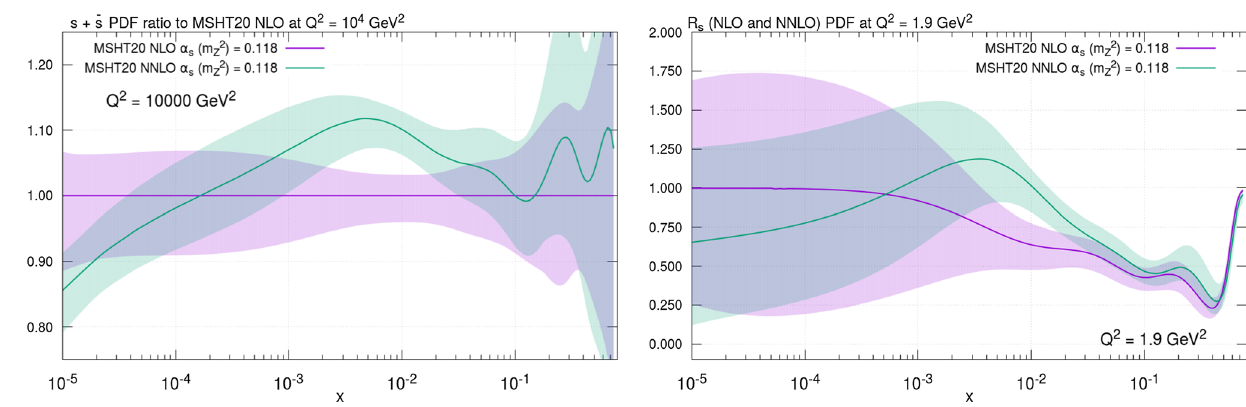
Fig. 41 (Left) s + ¯ s PDF showing the ratio of the MSHT20 PDFs to their NLO value at Q 2 = 10 4 GeV 2 . (right) R s PDFs showing the absolute values of the MSHT20 PDFs at NLO and NNLO at Q 2 = 1 . 9 GeV